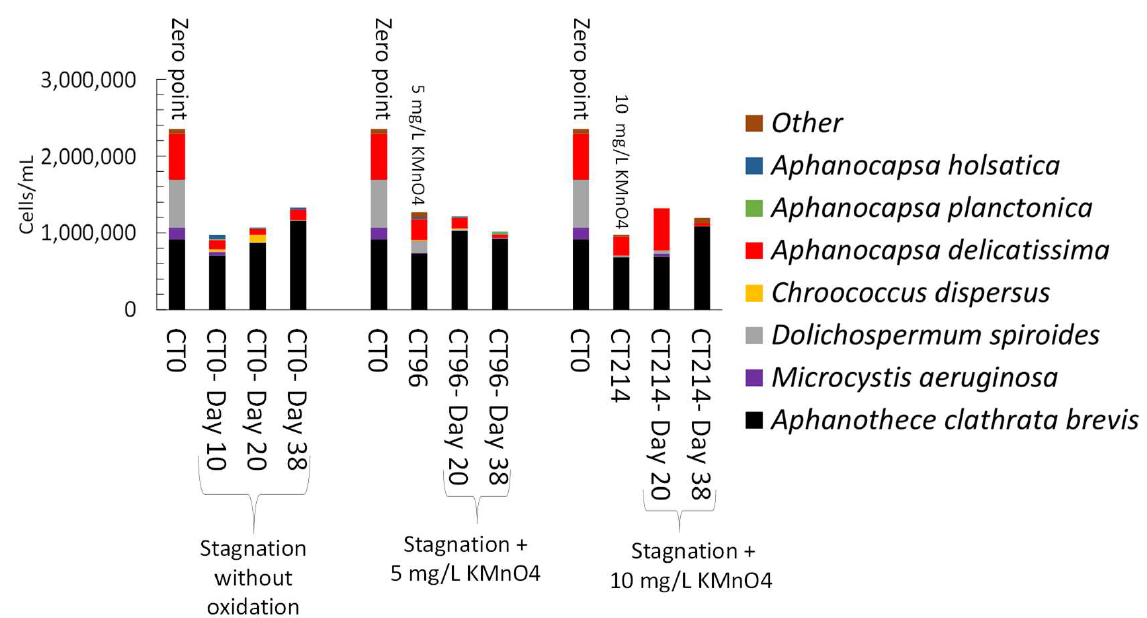
Figure 2. Fate of cyanobacterial cells (taxonomic cell counts) during sludge oxidation and stagnation in the laboratory on 7 August using 5, 10 mg/L KMnO 4 and 10, 20 mg/L H 2 O 2 . Zero point: Before oxidation, CT: exposure (mg · min/L), Day: stagnation day.